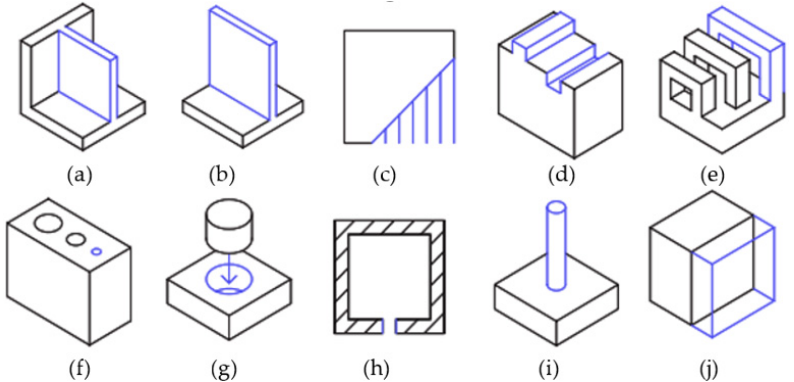
Figure 8. ( a ) Supported walls, ( b ) unsupported walls, ( c ) support and overhangs, ( d ) embossed and